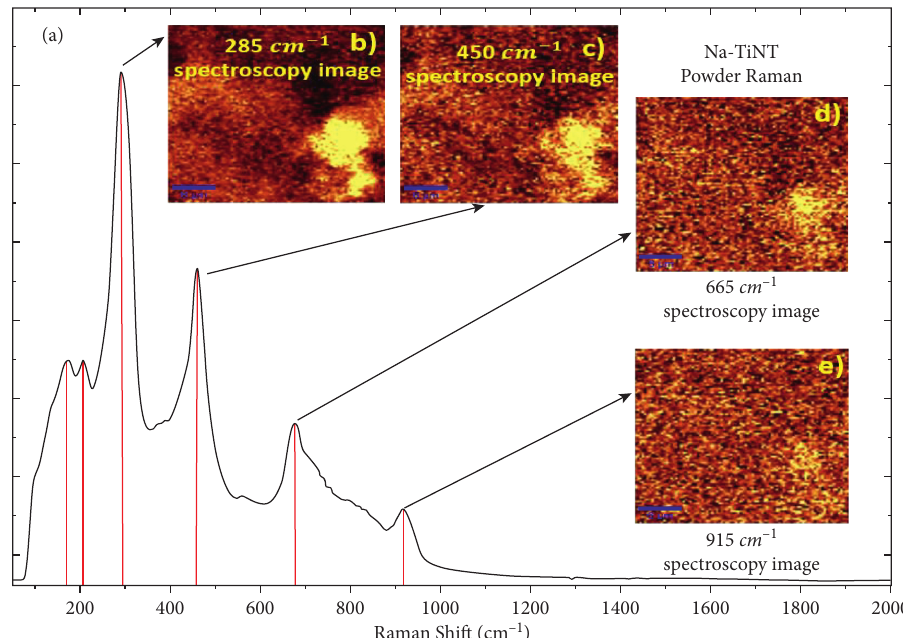
Figure 2: (a) Raman spectrum of the Na-TiNT, (b) spectroscopy image of the band 285cm − 1 , (c) spectroscopy image of the band 450cm − 1 , (d) spectroscopy image of the band 665 cm − 1 , and (e) spectroscopy image of the band 915cm − 1 .